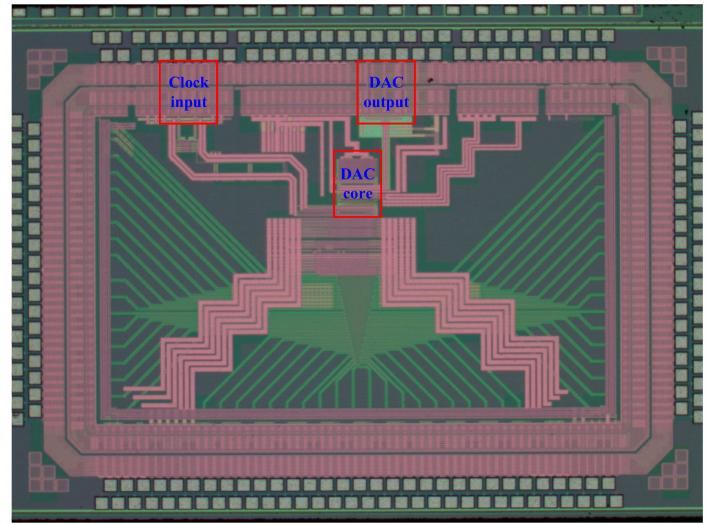
Figure 7. The micrograph of the DAC